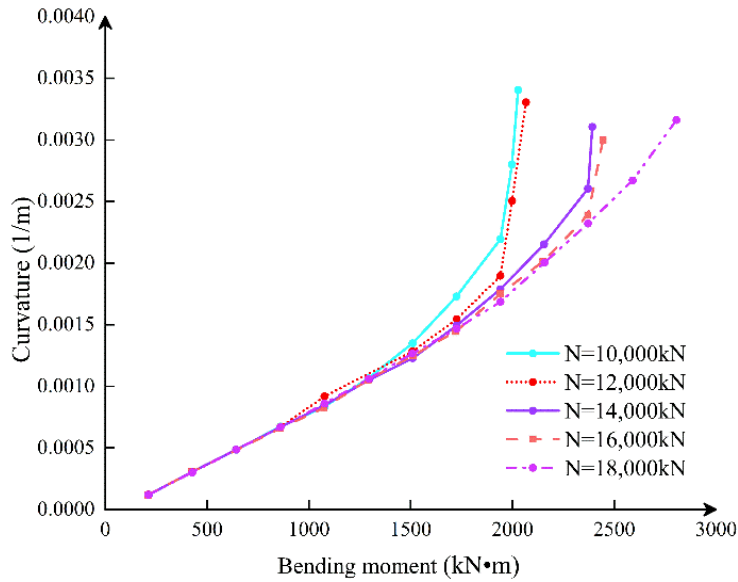
Figure 12. M– ϕ curves of joint under different axial pressures. Figure 12. M– φ curves of joint under different axial